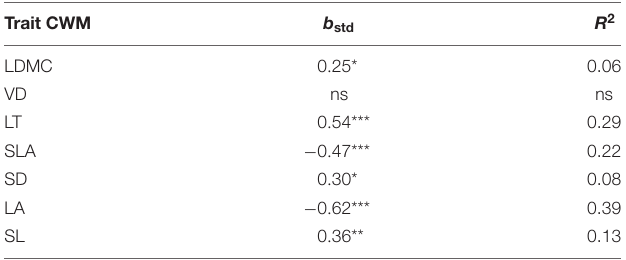
TABLE 3 | Standardized beta coefficients for relationships between the community weighted mean of seven leaf traits (Trait CWM) and the local hydrology, represented by height above nearest drainage